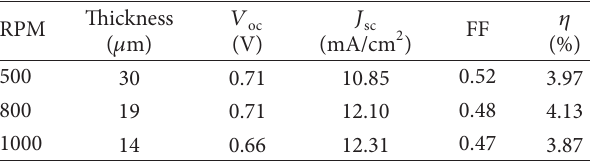
T 1: Photovoltaic parameters of the photoelectrode made at different spinning